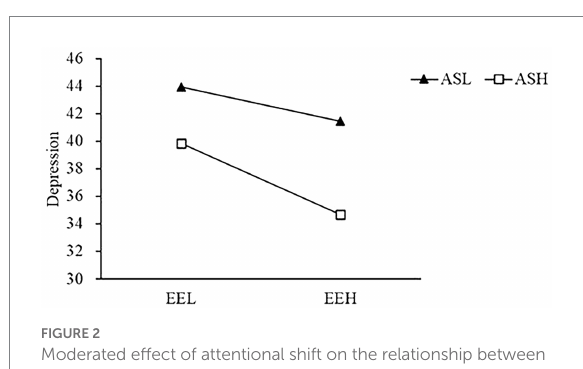
FIGURE 2 Moderated effect of attentional shift on the relationship between emotional empathy and depression. ASL, low attentional shift; RRH, high attentional shift; EEL, low emotional empathy; and EEH, high emotional empathy.